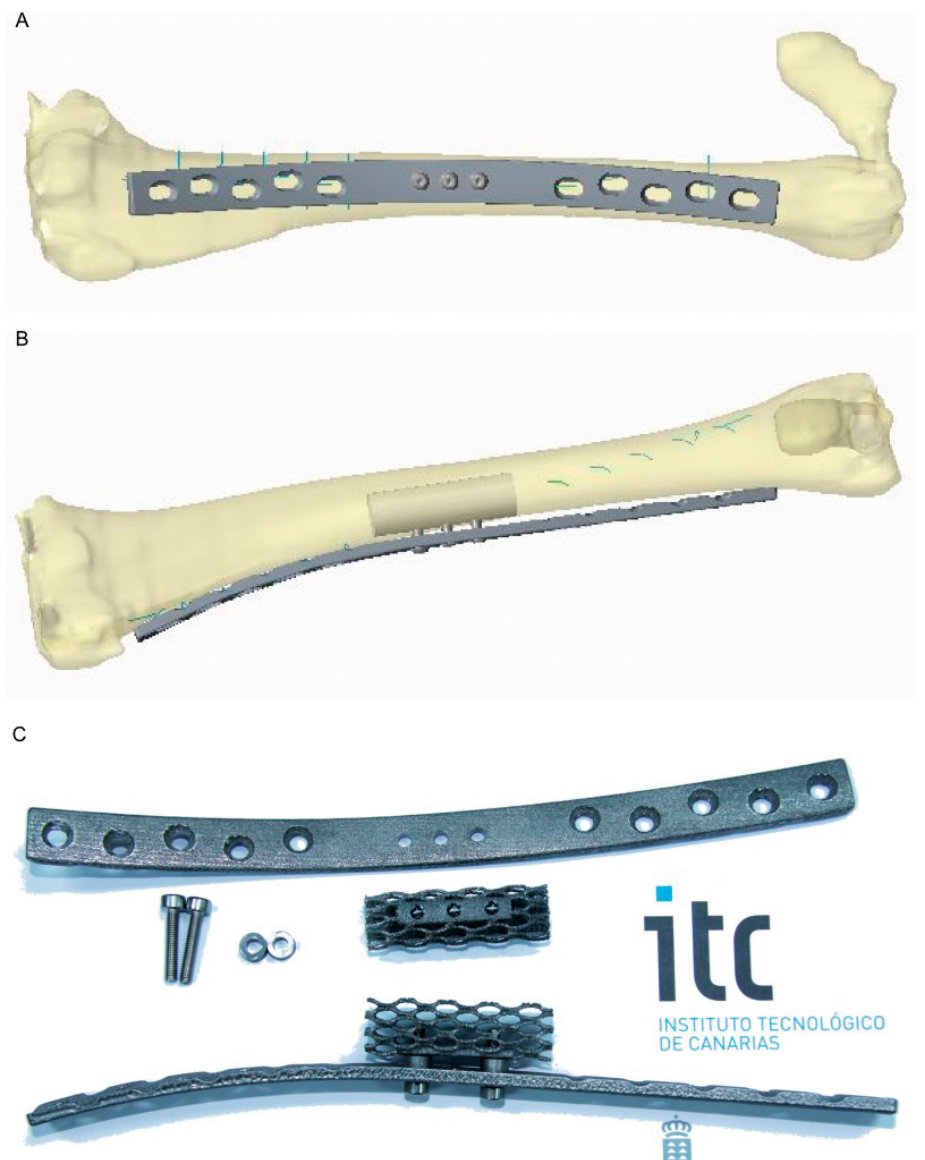
Figure 1. Computer-assisted design of the sca ff old and osteosynthesis plate. ( A ) Frontal view, showing the plate. ( B ) Lateral view, showing the position where the sca ff old should fit after the resection and how the osteosynthesis plate shape fits the tibial profile. ( C ) Electron beam melting (EBM)-sintered Ti 6 Al 4 V ELI sca ff old, osteosynthesis plate, and screws.